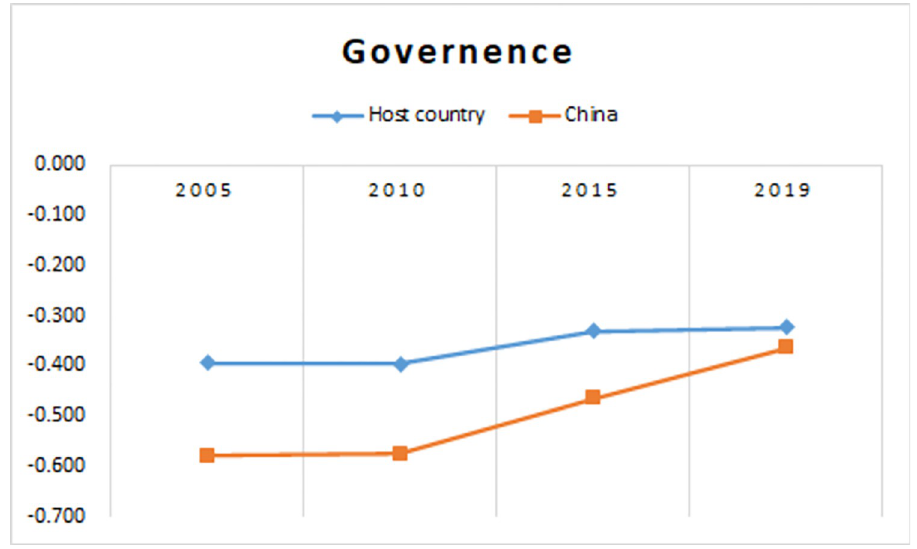
Fig 1. Governance line chart of Asian countries and China from 2005 to